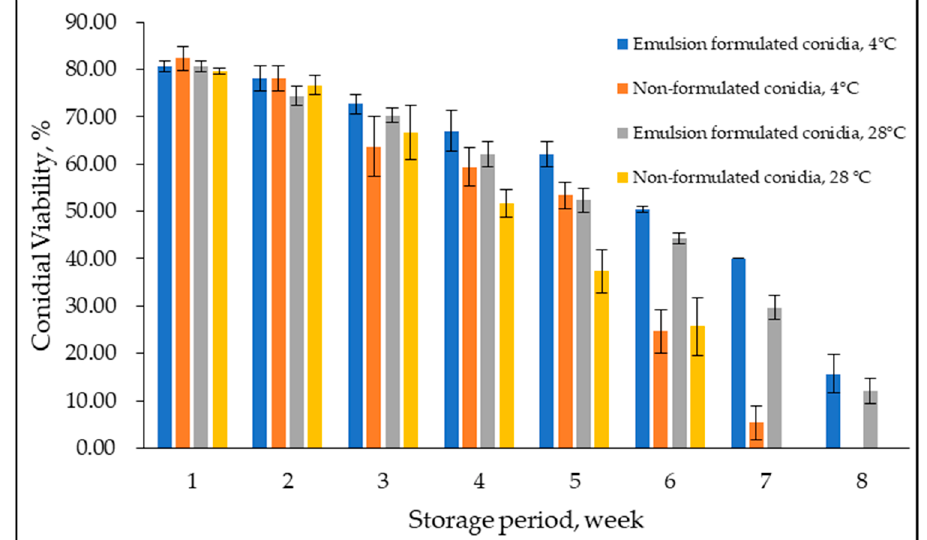
Figure 7. Effect of prolonged storage on emulsion formulated and non-formulated conidial viability at 4 °C and 28 °C. Bars represent mean ± standard deviation.